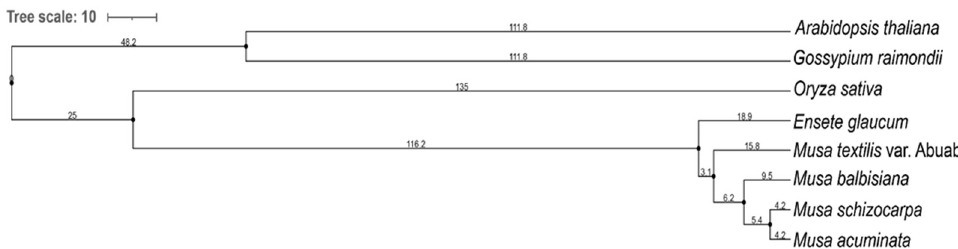
Figure 5. Phylogenetic tree of Musa textilis var. Abuab, four other Musa spp., Oryza sativa , and two outgroup species, Arabidopsis thaliana and Gossypium raimondii using OrthoFinder 2.5.2 Multiple Sequence Alignment, set to use MAFFT 7.475 and RAxML